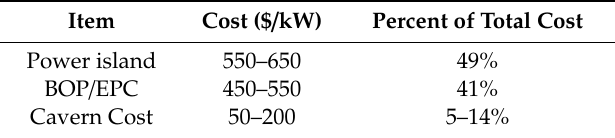
Table 33. CAES capital cost breakdown by component, Siemens (2017) [150].